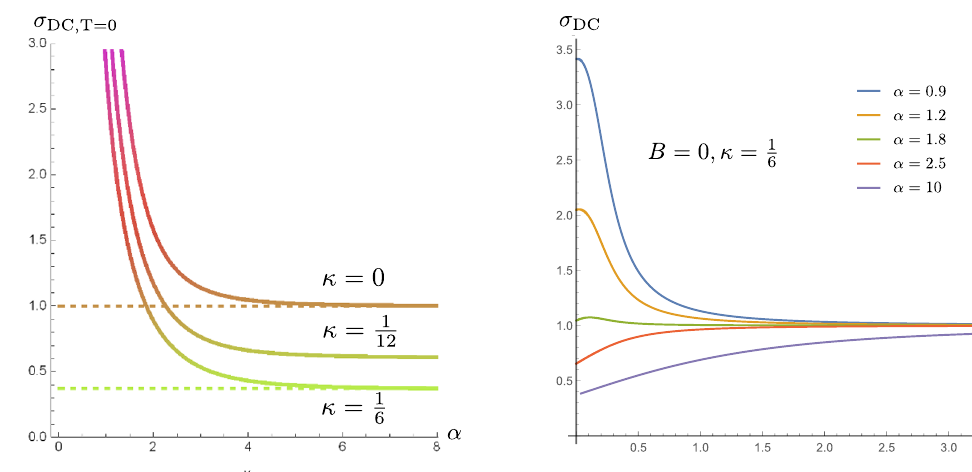
Figure 3 . Electric DC conductivity (cid:27) DC for the Exponential model in the absence of an applied magnetic (cid:12)eld. Left: (cid:27) DC at zero temperature as a function of the disorder strength (cid:11) for di(cid:11)erent theory parameter (cid:20) . Right: the temperature dependence of conductivity for (cid:20) = 1 = 6 at di(cid:11)erent (cid:11) . In zero magnetic (cid:12)eld (cid:27) DC is bounded from below and its lowest value is about 0 : 368. We worked in units with the charge density (cid:26) = 1.